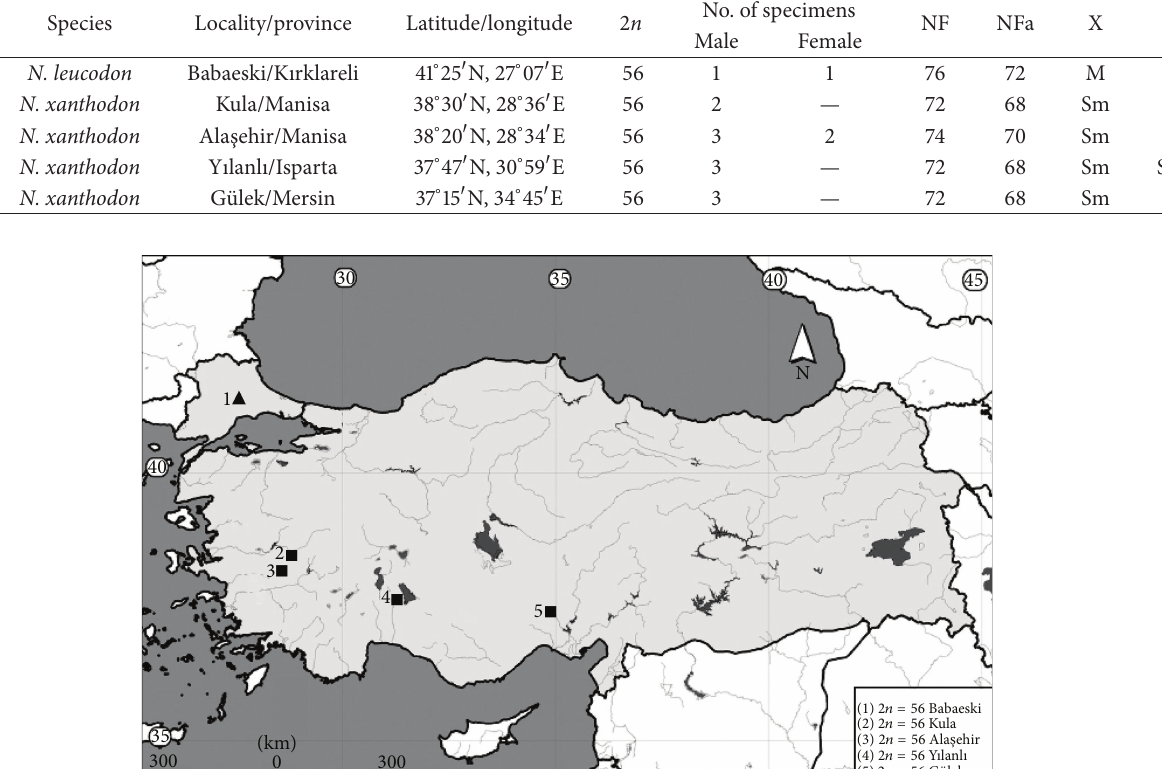
Figure 1: Collecting sites of Nannospalax leucodon ( 󳵳 ) and N. xanthodon ( ◼ ) in Turkey. The numbering of sampling localities corresponds to data in Table